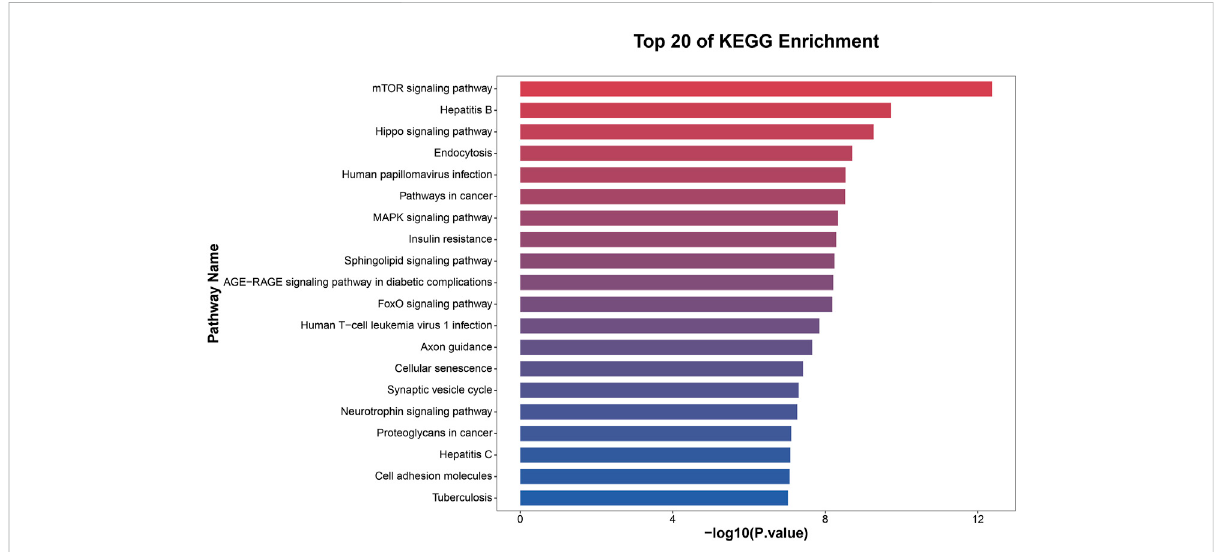
FIGURE 11 KEGG pathway signi fi cance ranking map ( p ≤ 0.05). The x -axis presents enrichment ratios, and the y -axis presents KEGG